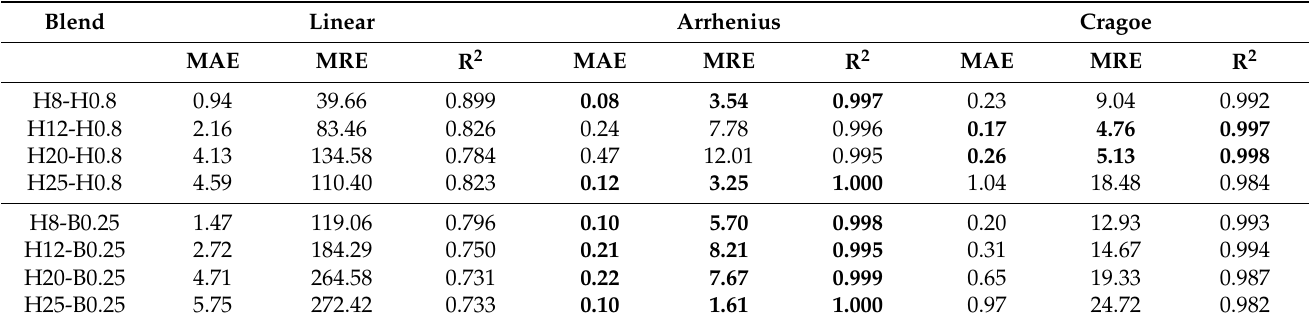
Table 7. 𝑀𝐴𝐸 (in g/10 min), 𝑀𝑅𝐸 (in %) and 𝑅 (cid:2870) for pipe material blends. Blend Linear Table 7. MAE (in g/10 min), MRE (in %) and R 2 for pipe material blends.